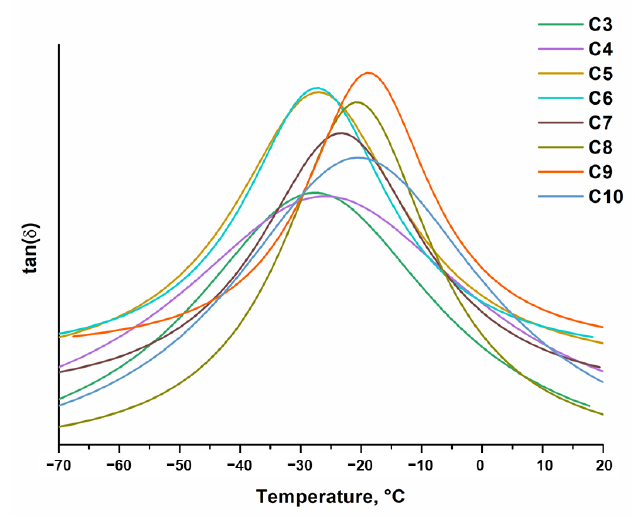
Figure 5. DMTA thermograms of photopolymers C3 – C10.